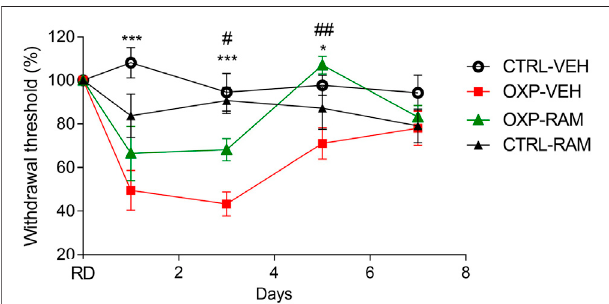
FIGURE 4 | Effects of ramipril on OXP-induced mechanical allodynia. Results are compared using mixed-effects model test followed by Tukey ’ s multiple comparisons test (Factor treatment: F 3.044, 102 (cid:1) 17.79, p < 0.0001, time: F 3, 36 (cid:1) 15.73, p < 0.0001 and interaction: F 12, 134 (cid:1) 4.653, p < 0.0001). Each group represents the mean of 8 – 10 animals, and the error bar indicates the SEM. *** p < 0.001, * p < 0.05 OXP-VEH vs. CTRL-VEH groups. ## p < 0.01, # p < 0.05 OXP-VEH vs. OXP-RAM groups. n (cid:1) 10 per group. OXP-treated mice received OXP at a cumulative dose of 15 mg/kg (5 mg/kg/3 days,intraperitoneal).RAM-treatedmicereceiveddailyinjectionof ramipril at the dose of 3 mg/kg (intraperitoneal). OXP: oxaliplatin, RAM: ramipril, RD: reference day, VEH: vehicle.